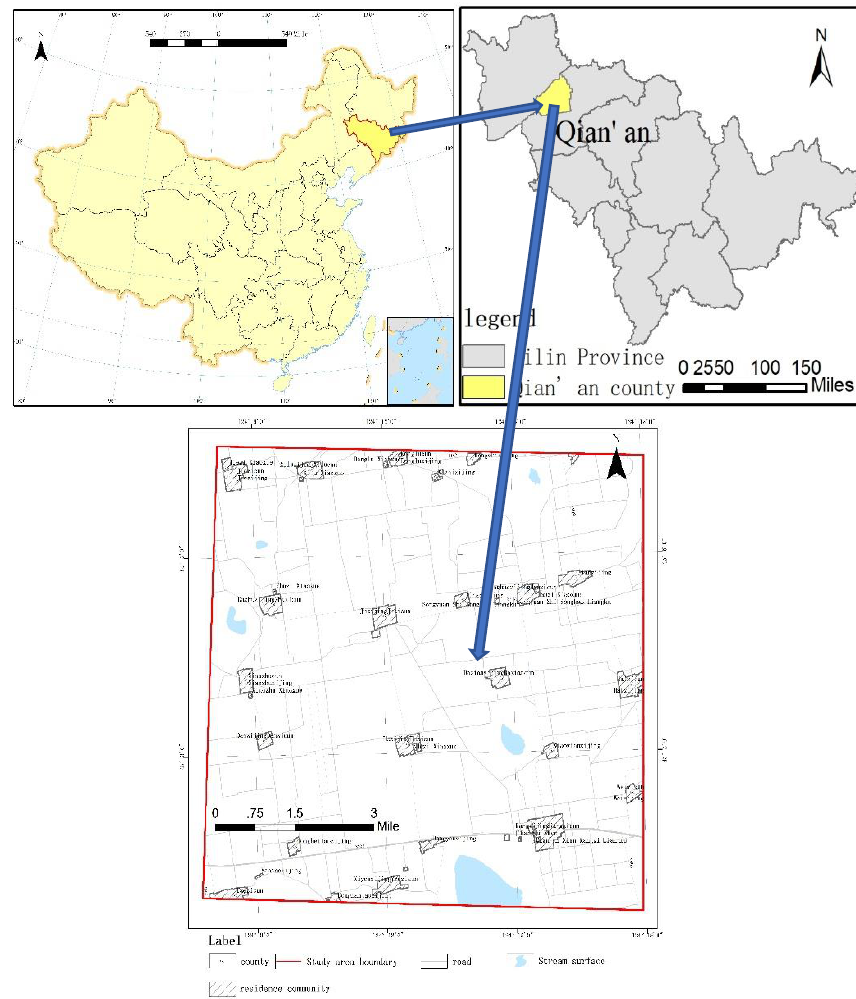
Figure 1. Geographical location of the study area.